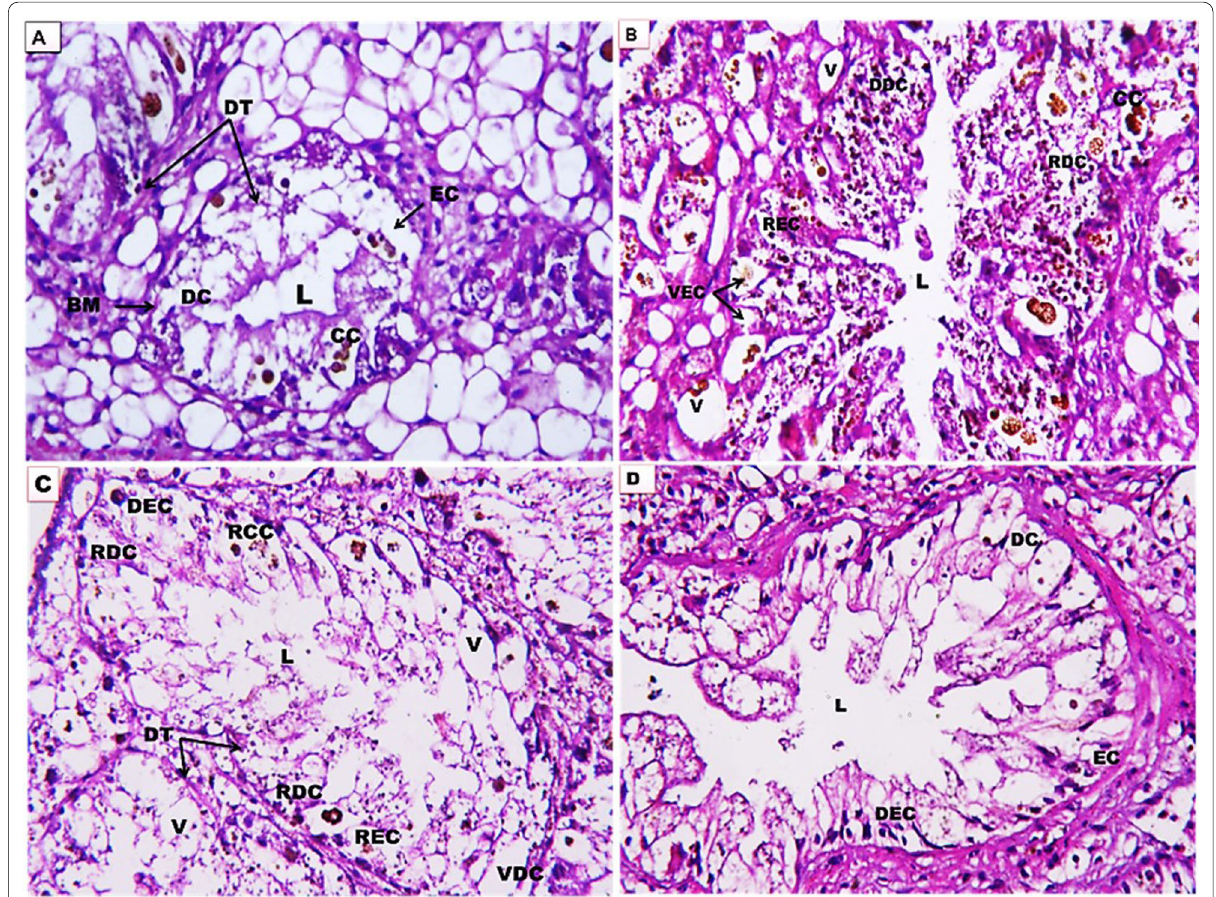
Fig. 1 Digestive gland of Eobania vermiculata snail. a Digestive gland of untreated E. vermiculata snail (control group) display regular structure with normal digestive tubule (DT) lined with digestive cells (DC), calcium cells (CC) and excretory cells (EC) resting on a basement membrane (BM) and are arranged around a narrow lumen (L). b Digestive gland of treated E. vermiculata snail after 1 day of chitosan LC 50 exposure exhibited rupture of digestive cells (RDC) and excretory cells (REC), vacuolated digestive cells (VDC), vacuolated excretory cells (VEC), degeneration of digestive cells (DDC) and the lumen (L) inside tubule increased in size. c Digestive gland of E. vermiculata snail exposed to LC 50 of chitosan for 3 days revealed deformation of cells where the lumen (L) is increased, many vacuoles (V) found and presence of vacuolated digestive cells (VDC). Many cells were ruptured and degenerated (RDC, RCC, REC and DEC). d Digestive gland of E. vermiculata snail after 7 days of chitosan LC 50 exposure showed moderate morphological changes, with normal digestive, excretory and calcium cells and some vacuoles, H&E ×